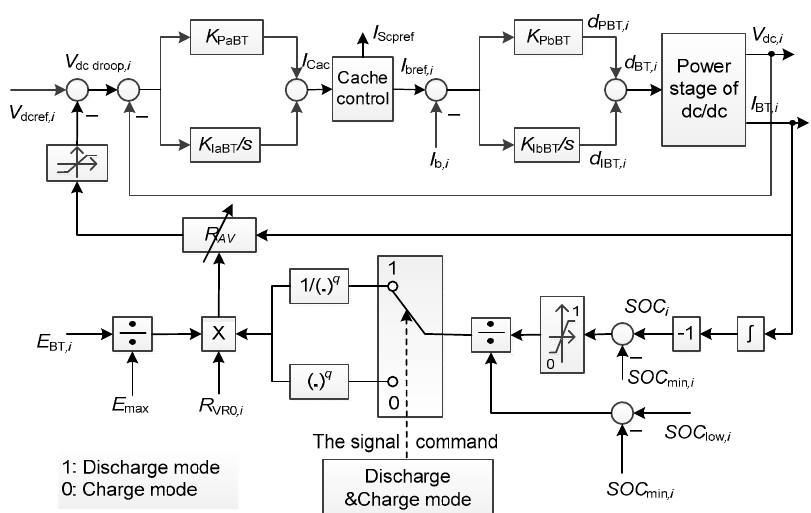
Figure 5. Diagram of the proposed control system for the i th BESS.